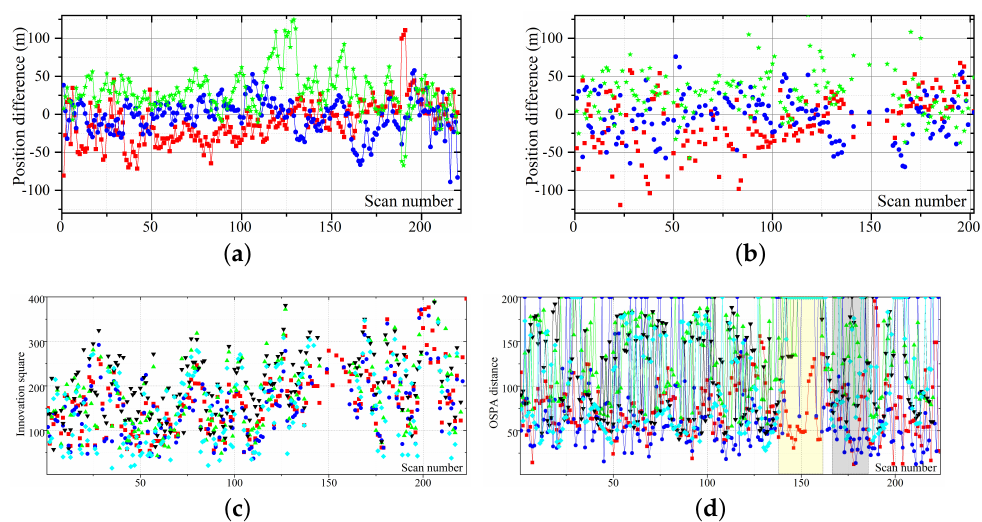
Figure 11. ( a ) The position difference between the smoothed track and ground truth of X, Y, and Z axes using the proposed method. ( b ) The position difference between the smoothed track and ground truth of X, Y, and Z axes using the ET-PHD filter [35]. ( c ) The innovation square of the proposed method and four comparisons [35–38]. ( d ) The OSPA distance of the proposed method and four comparisons [35–38]. Yellow rectangle means weak target scans. Gray rectangle means closely targeted scans. In ( c , d ), red squares mean the proposed method, blue balls mean the ET-PHD [35], green triangles mean the CPHD filter [36], black inverted triangles mean the Bernoulli filter [37], and cyan diamonds mean the GLMB filter